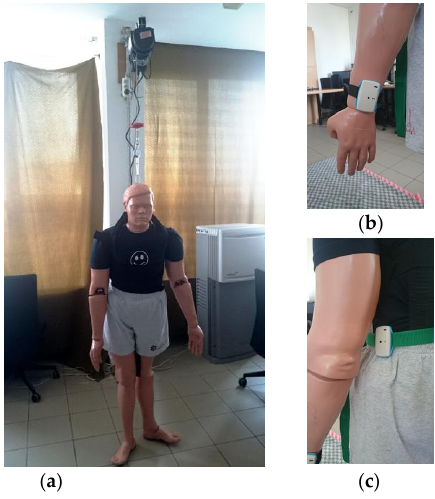
Figure 18. Manikin on the test site ( a ); and tags attached to the: wrist ( b ); and waist ( c ).